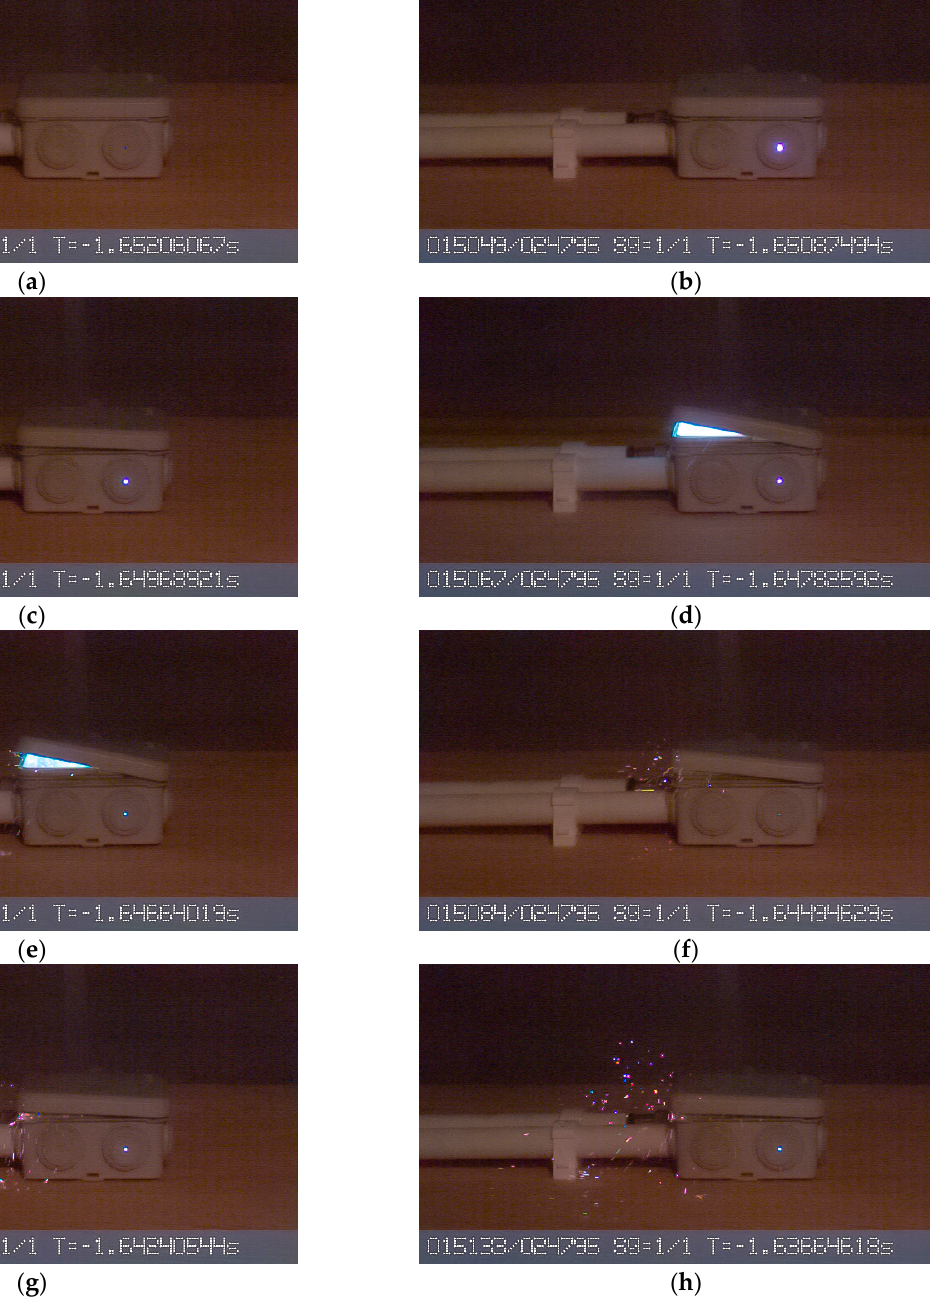
Figure 5. Photographic registration of the effects of the emergency arc in the electrical junction box ( a ) t 1 = 0 ms electric arc ignition; ( b ) t 2 = 1.15 ms switchgear opened; ( c ) t 3 = 2.3 ms pressure maximum for the first period time of arc ignition; ( d ) t 4 = 4.1 ms the pressure reduces to that before the ignition of the electric arc; ( e ) t 5 = 5.4 ms start of electric arc extinguishing; ( f ) t 6 = 7.1 ms electric arc re-ignition; ( g ) t 7 = 9.6 ms maximum pressure in the second period, the arc is burning; ( h ) t 8 = 15.3 ms final electric arc extinguishing ( I m = 1300 A, U = 230 V, Cu-Cu electrodes).